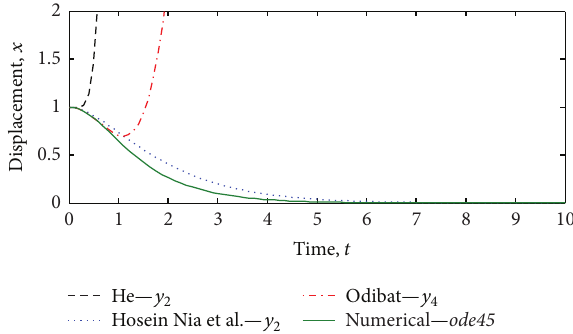
Figure 1: Comparison between the ode45 Runge-Kutta algorithm with respect to some homotopy perturbation approximate solutions of